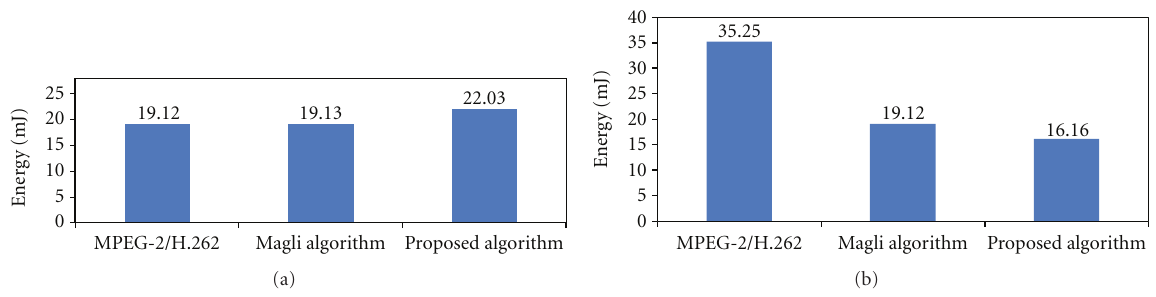
Figure 13: Comparing encoding energy consumption among algorithms for Akiyo video with: (a) the intraframe and (b) the interframe